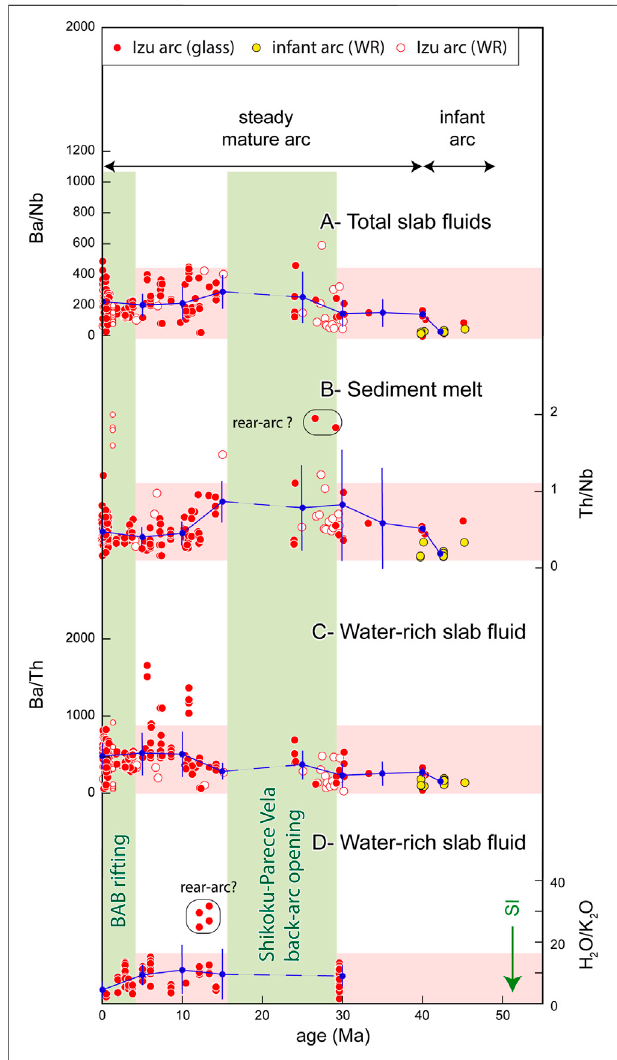
FIGURE 8 | Temporal evolution of the slab fl uids. The slab fl uid compositions are inferred from markers of slab dehydration, Ba/Th (A) and Rb/Th (B) , and sediment melts, Th/Nb (C) , as in (Pearce et al., 2005). (D) Temporal variations in H 2 O/K 2 O is also used to track the compositional fl uctuations of the water-rich slab fl uids over time. The slab- fl uid proxies display little variations over time. SI: subduction inception. The blue line represents an averaged composition with 1 σ error